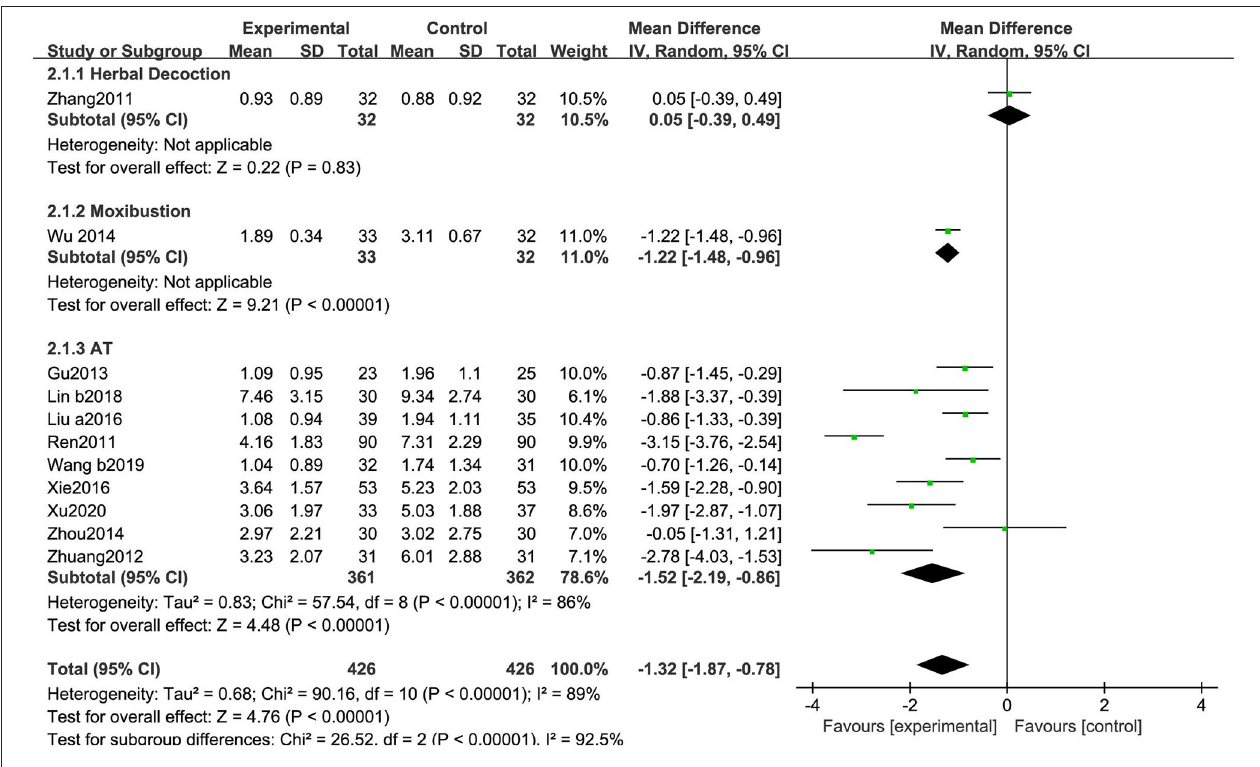
FIGURE 8 | Comparison of acupuncture related therapies in terms of UPDRS-IV.